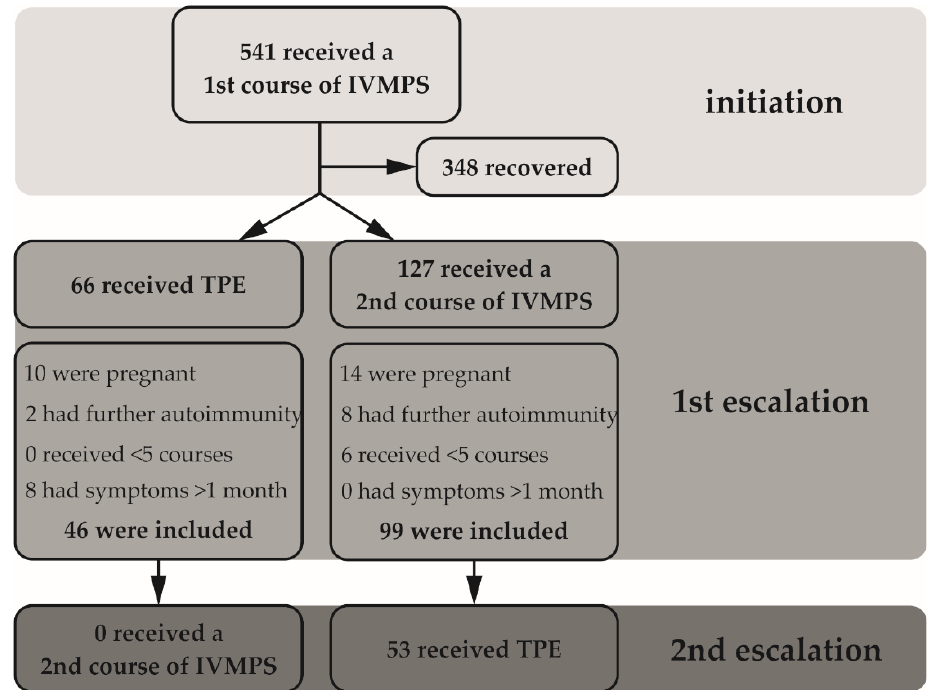
Figure 1. RRMS in-patients who were treated at the study site between January 2013 and December 2017 are described here. The data focus on those patients who received a full course of intravenous methyl prednisolone (5 x 1 g IVMPS) as the first escalation treatment after relapse. Patients